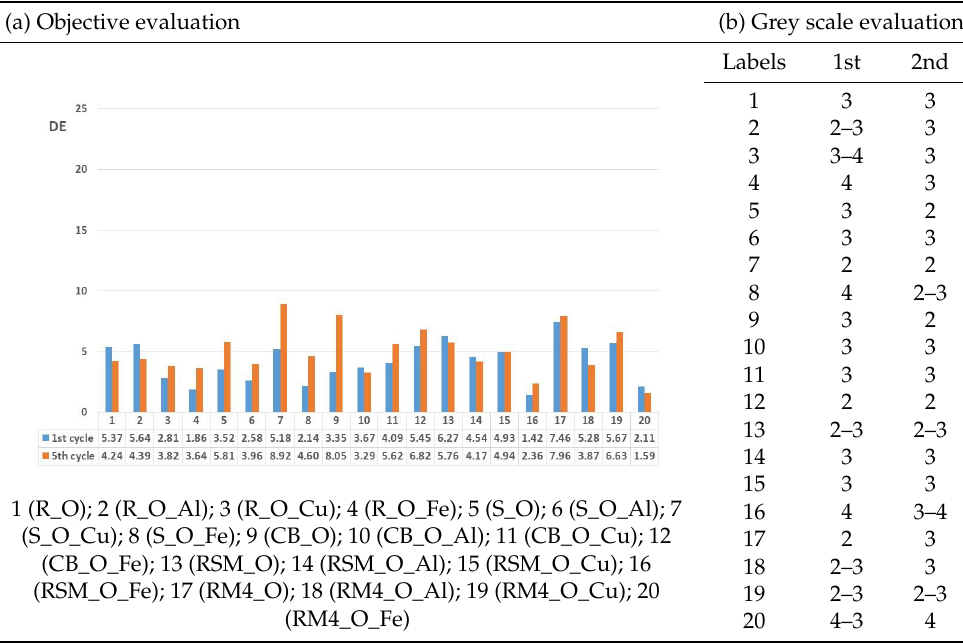
Table 8. Colour fastness to washing after 1st and 5th cycles of washing of cotton yarns dyed with pomegranate peel.